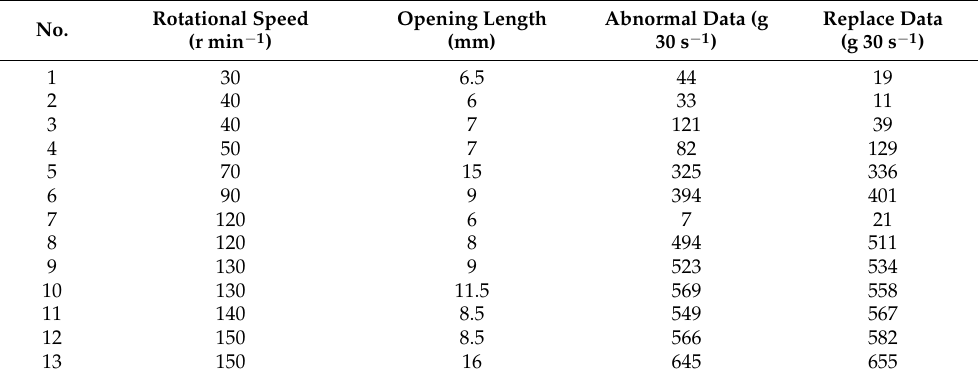
Table 2. Elimination and replacement of outliers.